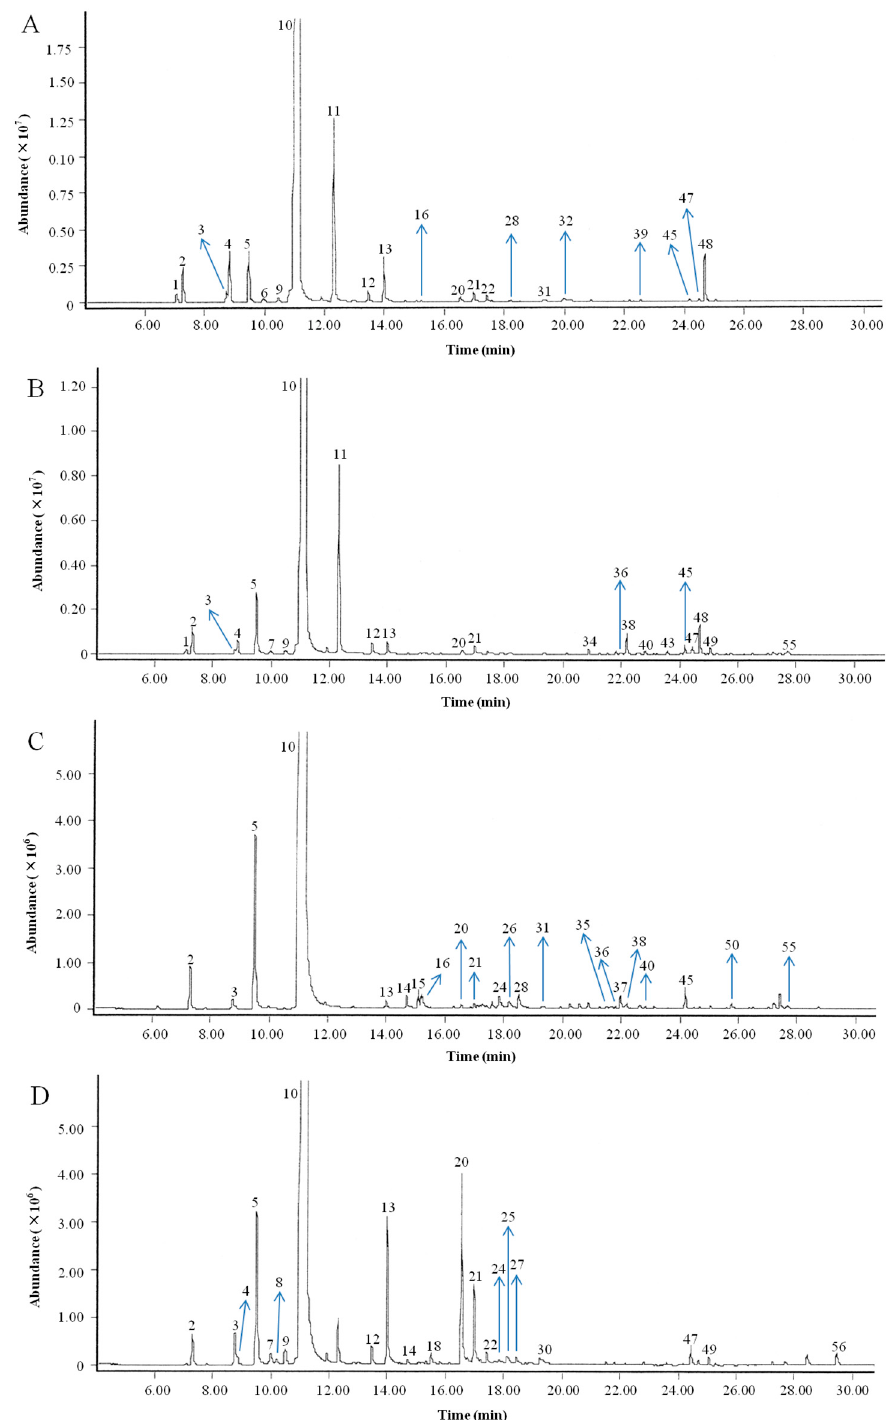
Figure 1. Total ion chromatograms of the four citrus EOs. ( A ) Nanfeng mandarin EO (NMEO). ( B ) Xunwu mandarin EO (XMEO). ( C ) Yangshuo kumquat EO (YKEO). ( D ) Physiological drop of Gannan Newhall navel orange EO (PDEO).